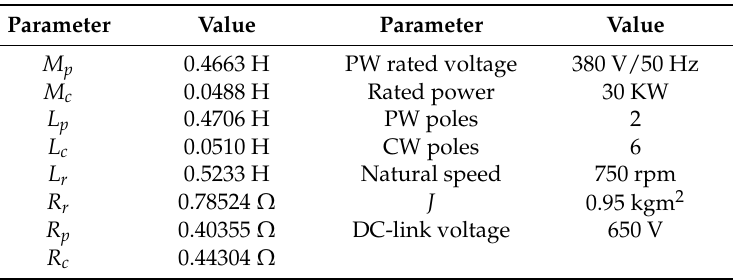
Table 1. Parameters of 30 kW BDFIM provided by manufacturer.